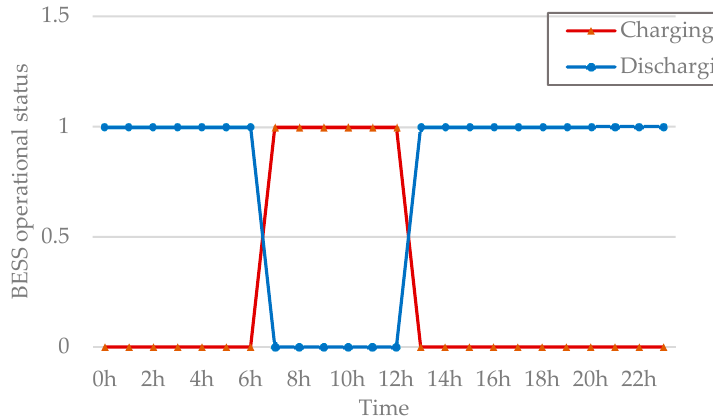
Figure 5. Operational status of the BESS.